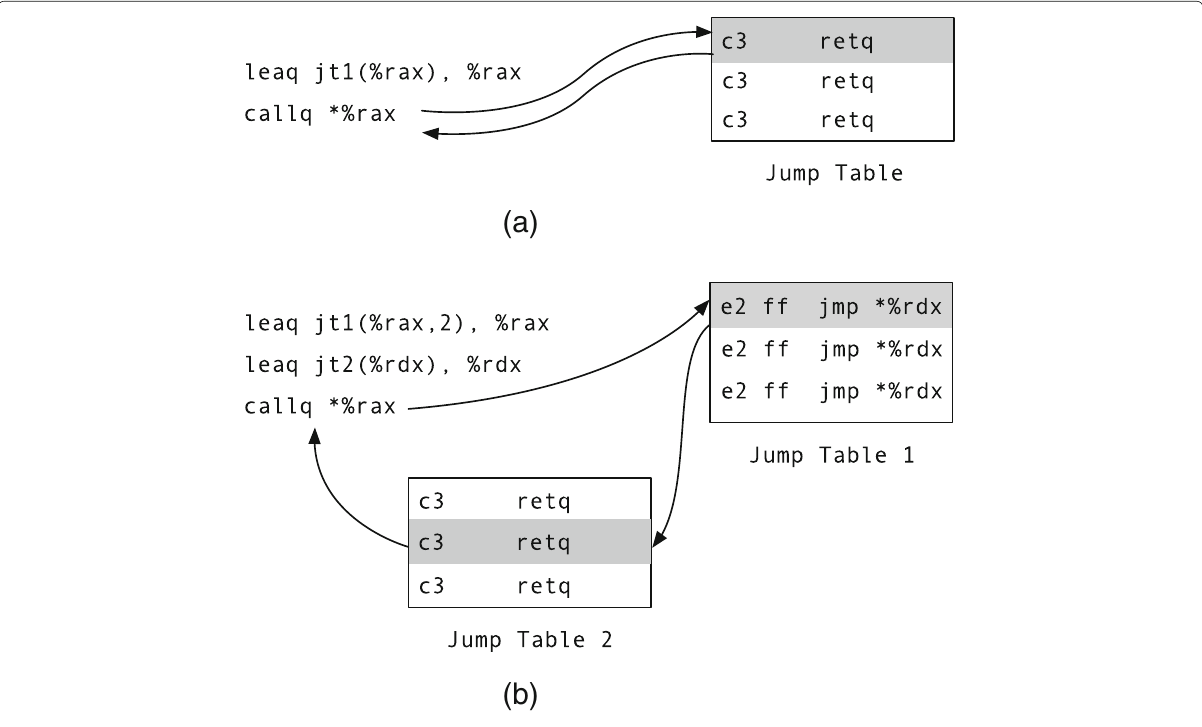
Fig. 4 Jump tables. a One-Step Jump. b Two-Step